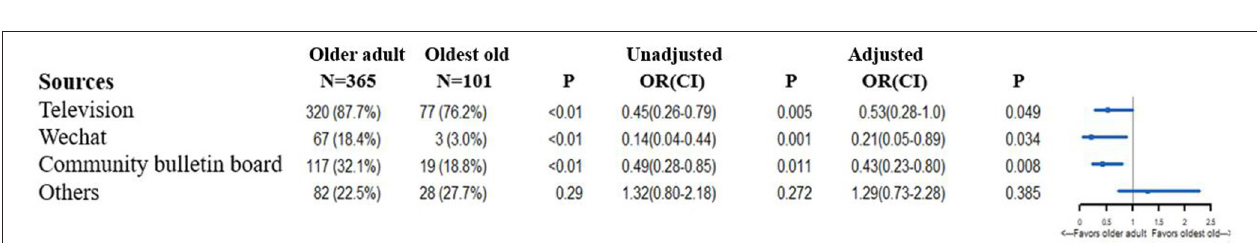
FIGURE 2 | Differences in the awareness of stroke-related knowledge between older adults and the oldest old. OR, Odds Ratio; CI, Confidence Interval; EMS, emergency medical service. Acute stroke therapy included thrombolytic therapy and endovascular therapy. Stroke educational tools included FAST and Stroke 1-2-0. In the multivariable logistic regression analysis, we adjusted gender, educational background, smoking history, drinking habit, hypertension, diabetes, myocardial infarction, prior stroke, dyslipidemia, cancer history, atrial fibrillation. The OR means the comparison between the older adults and oldest old (oldest old vs. the older adults).